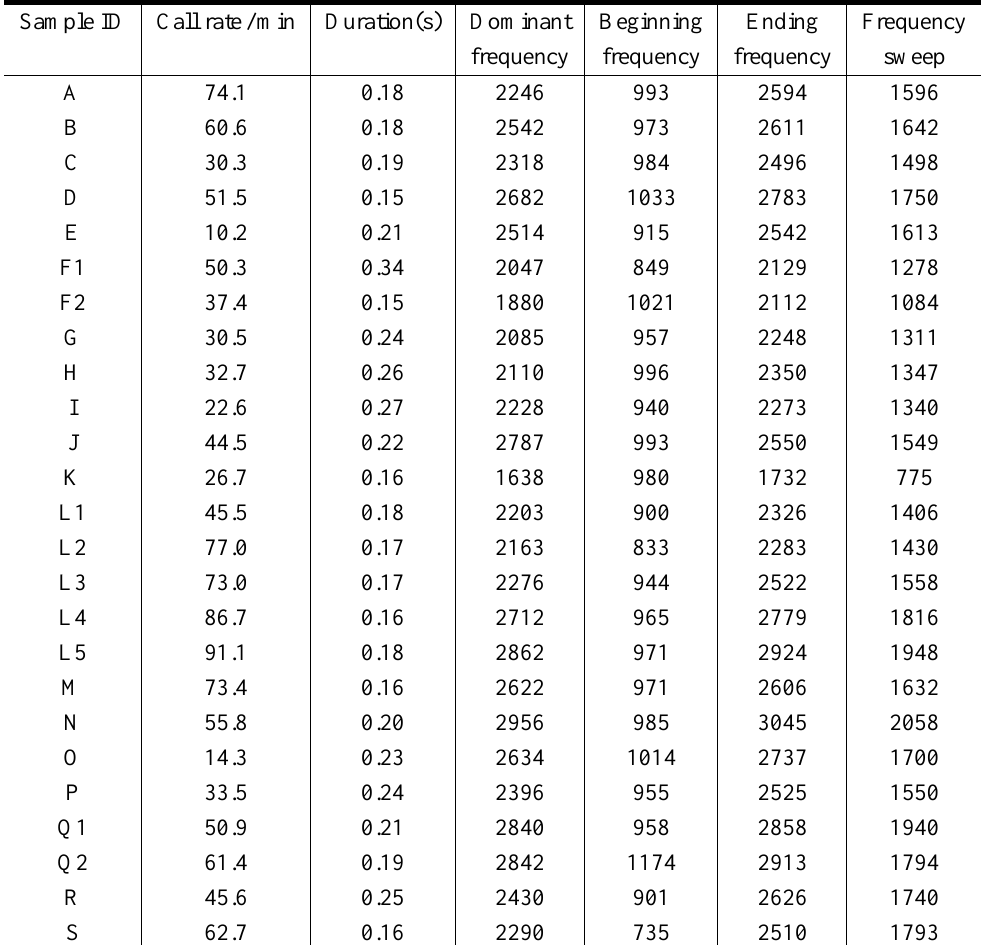
Mean values for variables taken from recordings with associated temperature data. All variables except for beginning frequency standardized to 25 o C. Sample IDs are those used in multidimensional scaling analyses 1